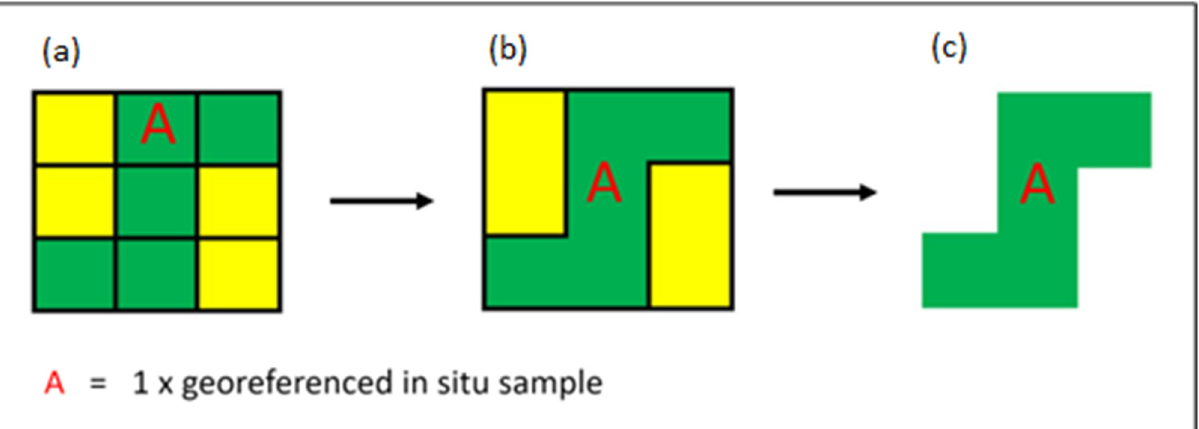
Figure 3. Example of object-based segmentation applied to an illustration depicting pixels. ( a ) Con- sists of 5 × green pixels and 4 × yellow pixels, ( b ) shows the result of object-based segmentation where all 5 × green pixels have been grouped into 1 × green object and 2 × yellow objects. The red A represents a georeferenced in situ reference sample which in ( a ) represents 1 × pixel, however, after OBIA segmentation in ( b , c ) it now represents 1 × green object consisting of 5 × grouped